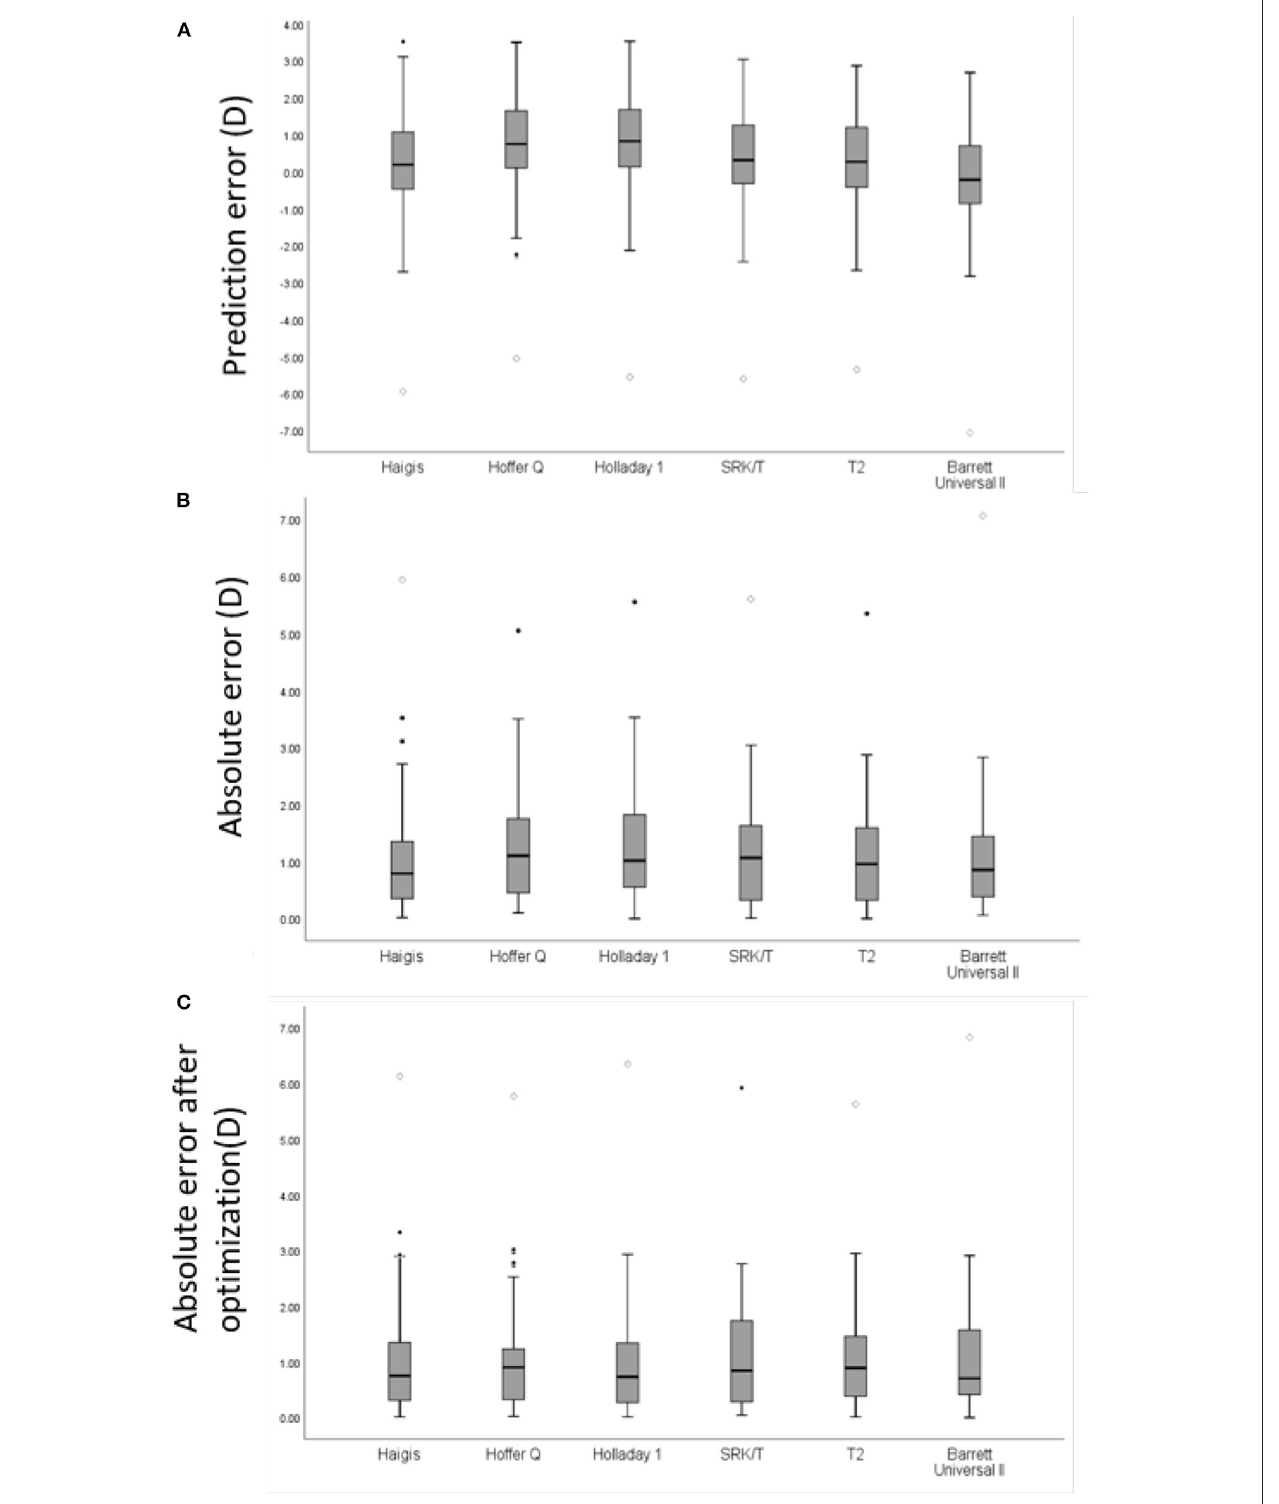
FIGURE 1 | A box plot of mean refractive error of intraocular lens power prediction in all eyes with AL ≥ 28.0mm. (A) Prediction error (PE) of each formula. (B) Absolute error (AE) of each formula in all eyes. (C) AE of each formula in all eyes after zeroing out the mean PE. Round mark (•) means outlier values between 1.5 to 3 box lengths from either end of the box; diamond mark ( ♦ ) means extreme values that are more than 3 box lengths from either end of the box.